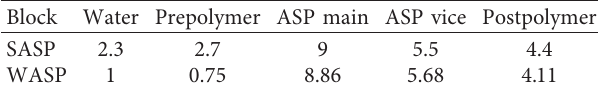
Table 19: Average well production